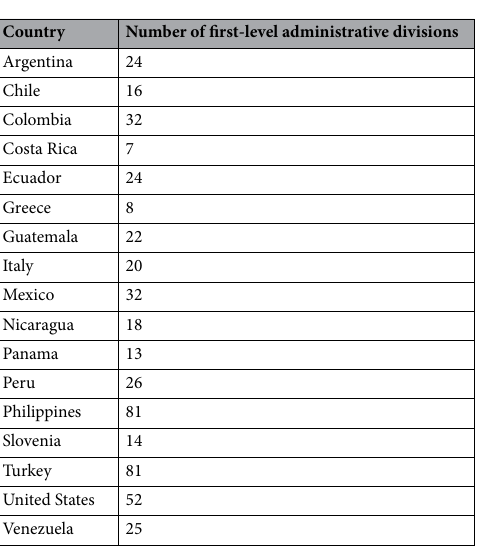
Table 1. Number of first-level administrative divisions by